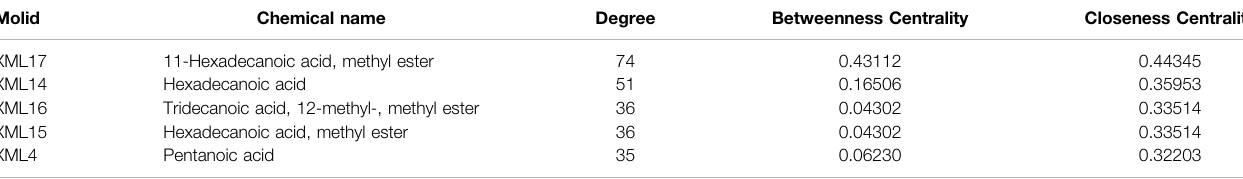
TABLE 4 | Putative main compounds in XML injection associated with prevention of myocardial ischemia. Molid